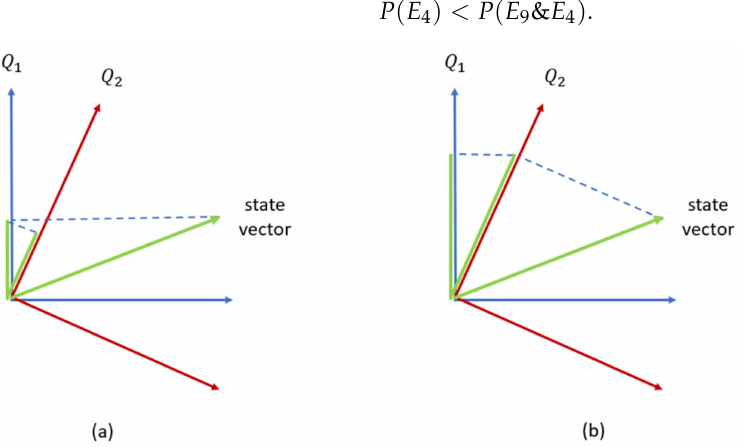
Figure 4. Denote by | ψ (cid:105) the state vector, and let Q 1 , Q 2 be two questions with their corresponding basis vectors { e 1 , e 1 , e 2 , e 2 } , and denote by Π e asking Q 1 and then Q 2 on the state vector, i.e., (cid:107) Π e and then Q 1 on the state vector, i.e., (cid:107) Π e